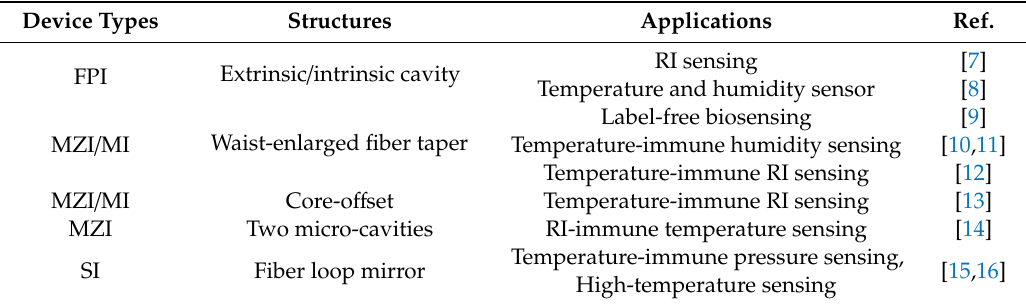
Table 1. A summary of sensing application based on fiber-optic interferometer.